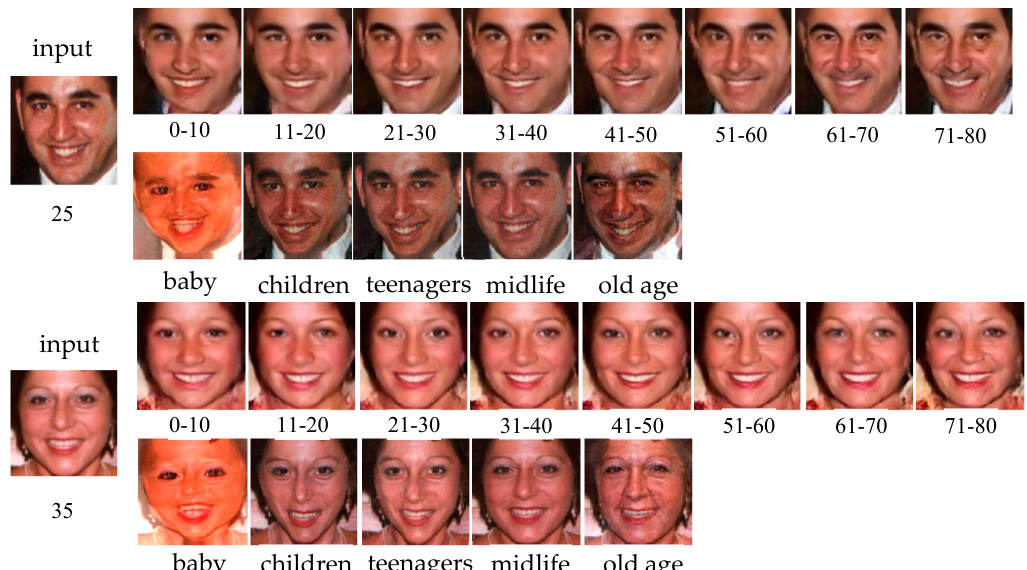
Figure 12. Compared with the Face Transformer (FT) Demos.